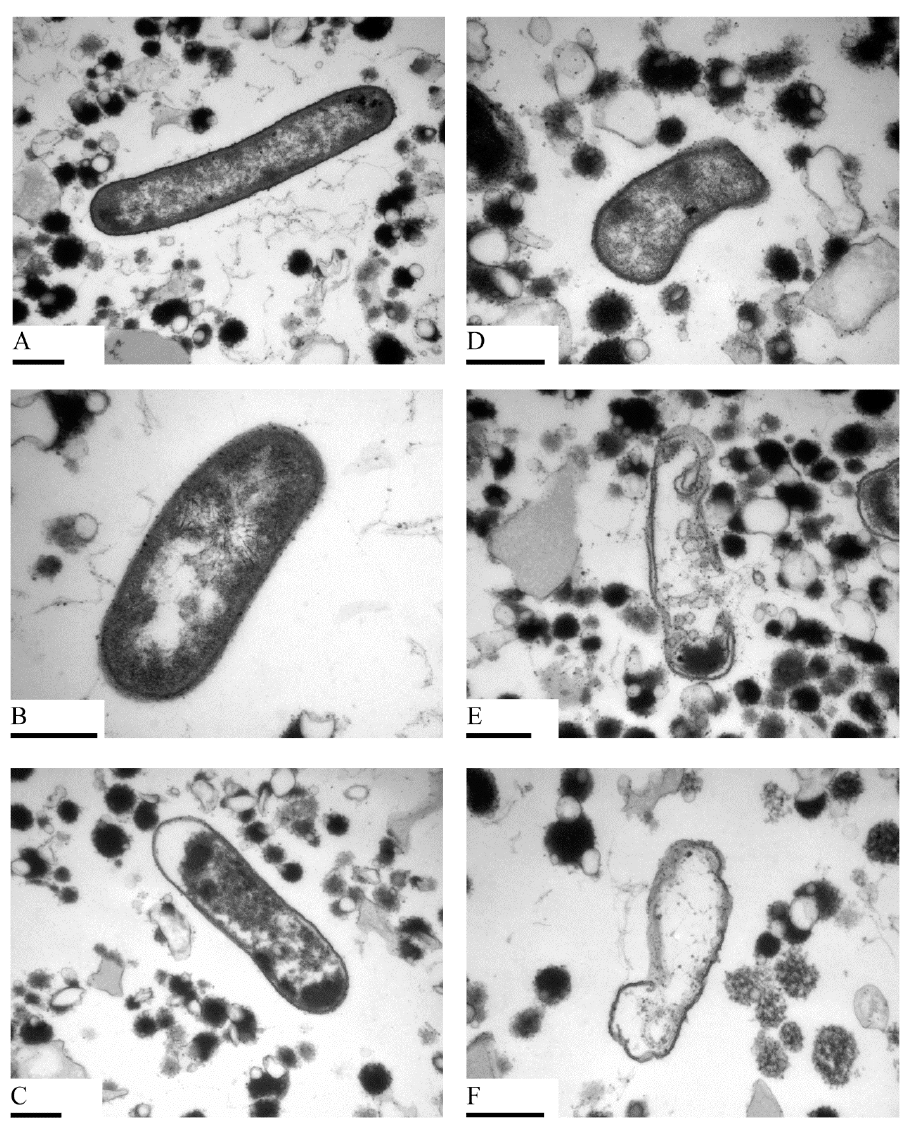
Figure 4. Transmission electron micrographs of E. coli resulting from different treatments: ( A ) control group (×40,000); ( B ) freezing (×80,000); ( C ) HP 400 MPa (×40,000); ( D ) LTHP 200 MPa (×60,000); ( E ) LTHP 400 MPa (×50,000); ( F ) LTHP two-cycle 400 MPa (×60,000). The scale bars represent 0.5 µm.